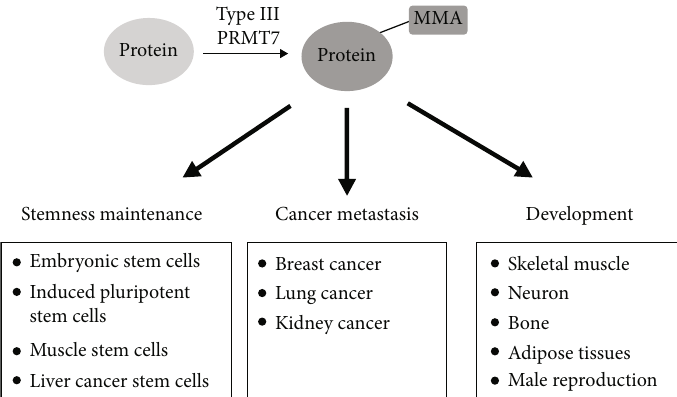
Figure 1: Biological functions of PRMT7 in mice and humans. PRMT7, a type III protein arginine methyltransferase, regulates the proliferation and di ff erentiation of stem cells and promotes cancer metastasis. De fi ciency of PRMT7 causes developmental defects in many systems. PRMT7: protein arginine methyltransferase 7; MMA: monomethyl